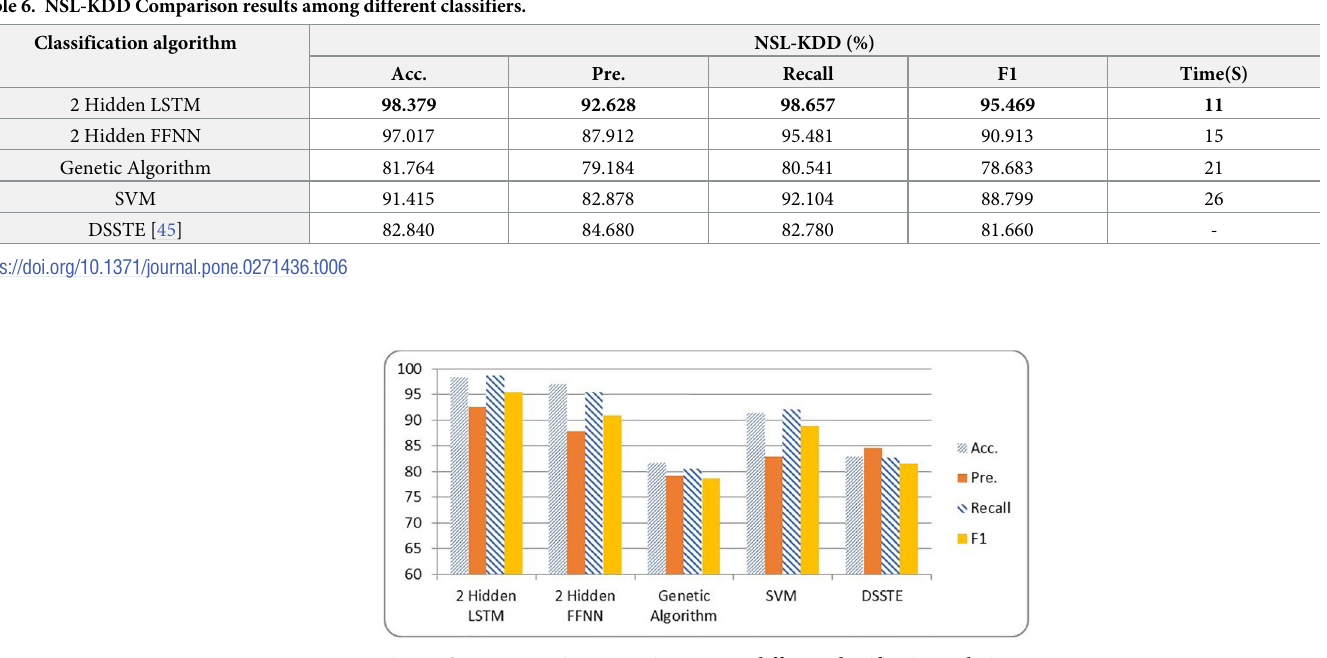
Fig 7. NSL-KDD metrics comparison among different classification techniques.